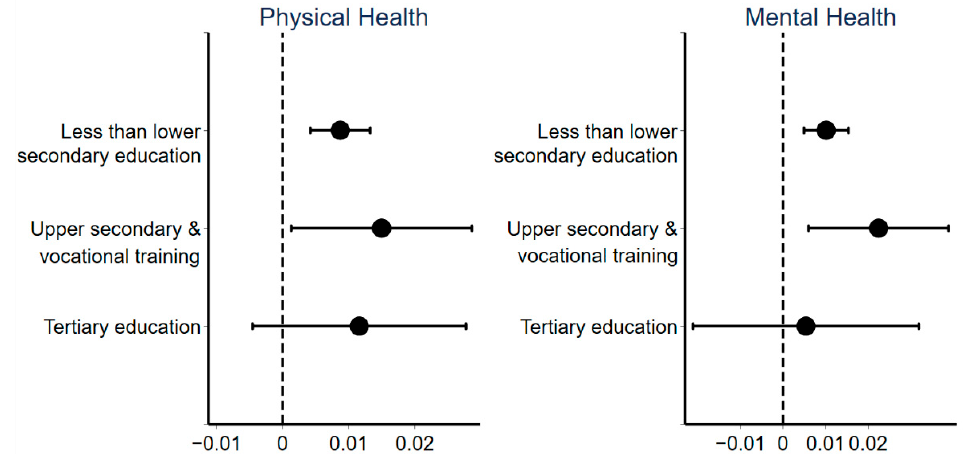
Figure 5. Coefficients and 90% confidence intervals of regressions for different education groups.